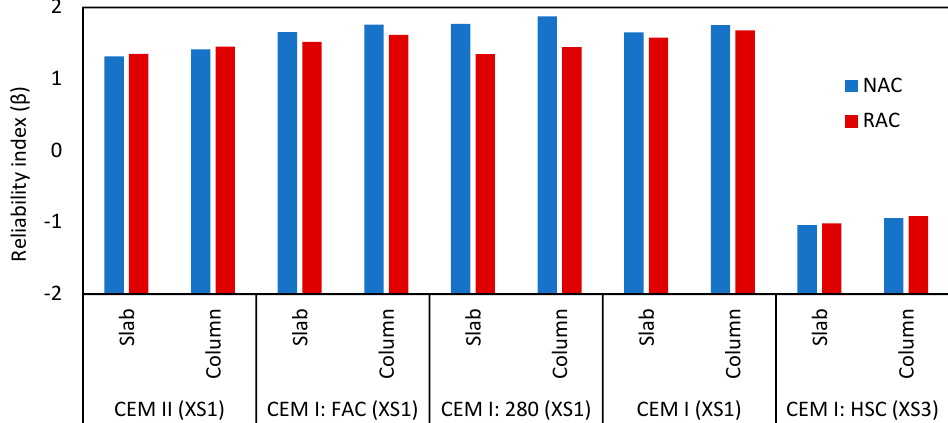
Figure 6. Reliability indices of all cases studies. No changes to cover design due to RA.